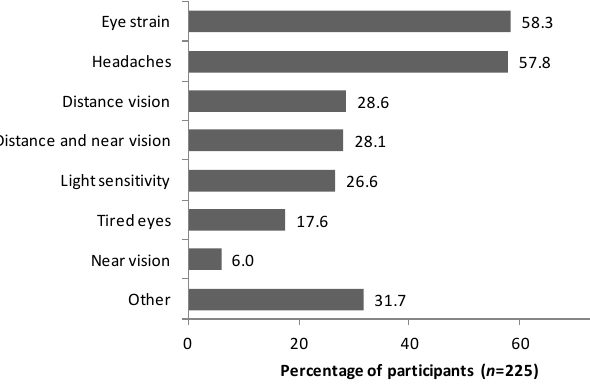
Figure 1. Complaints potentially indicative of vision problems. Complaints listed as other included, for example, ocular itching and